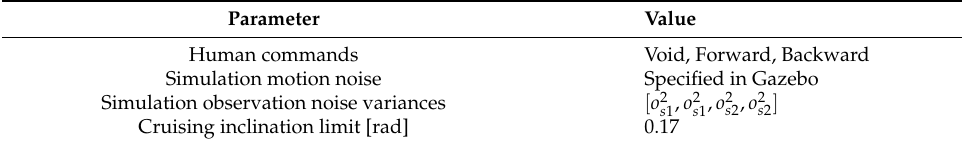
Table 1. Parameters for simulation.